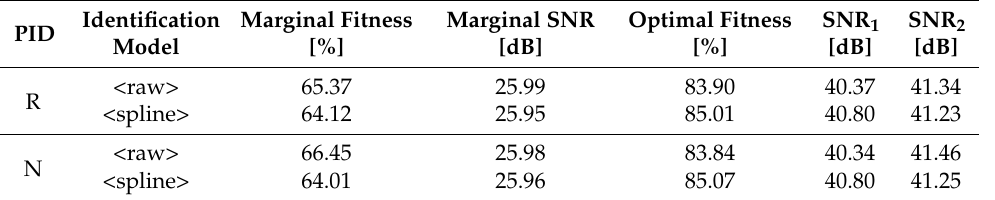
Figure 24. Fitness robustness surfaces depending on exogenous noise variances. Table 7. Robustness margins of PID controllers depending on output SNR.